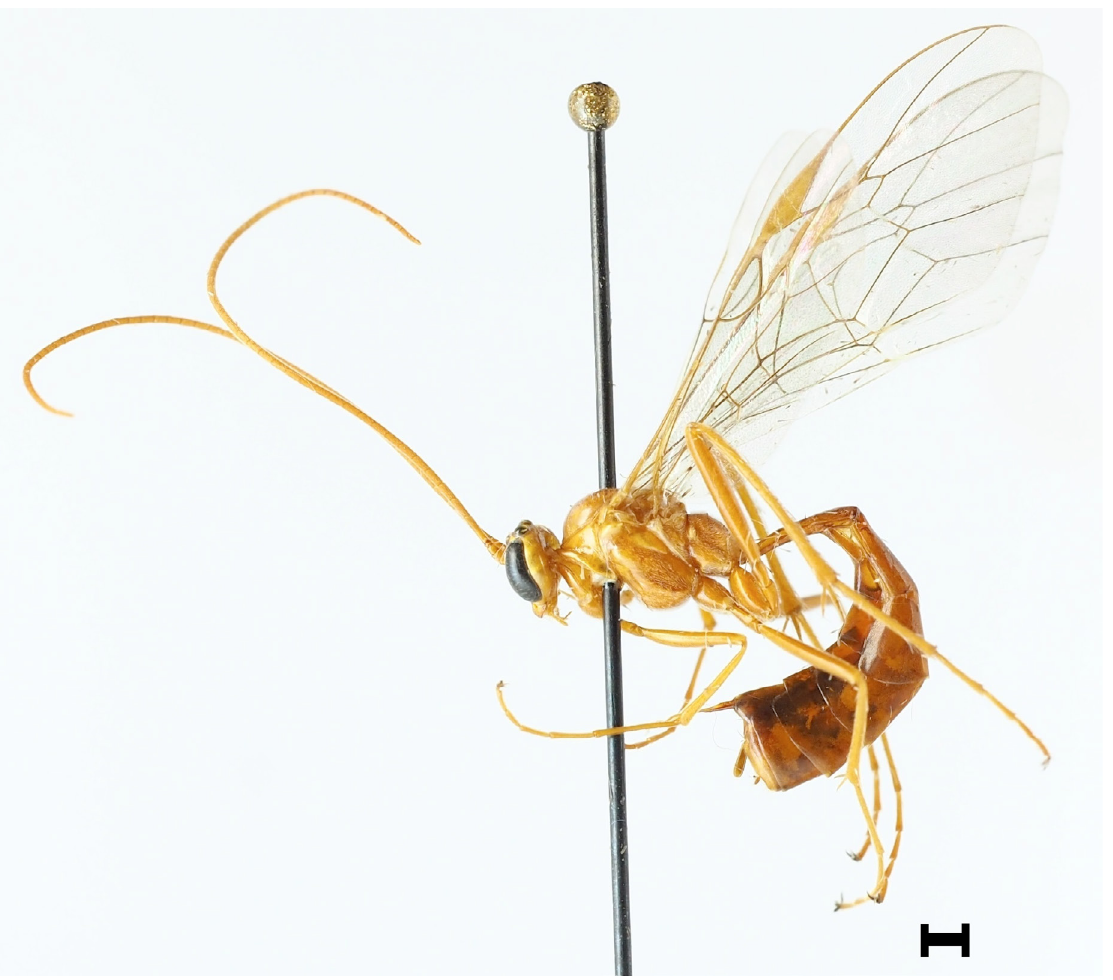
Fig. 34. Ophion kallanderi Johansson sp. nov., paratype, ♀ (MZLU 6371:5). Scale bar = 1